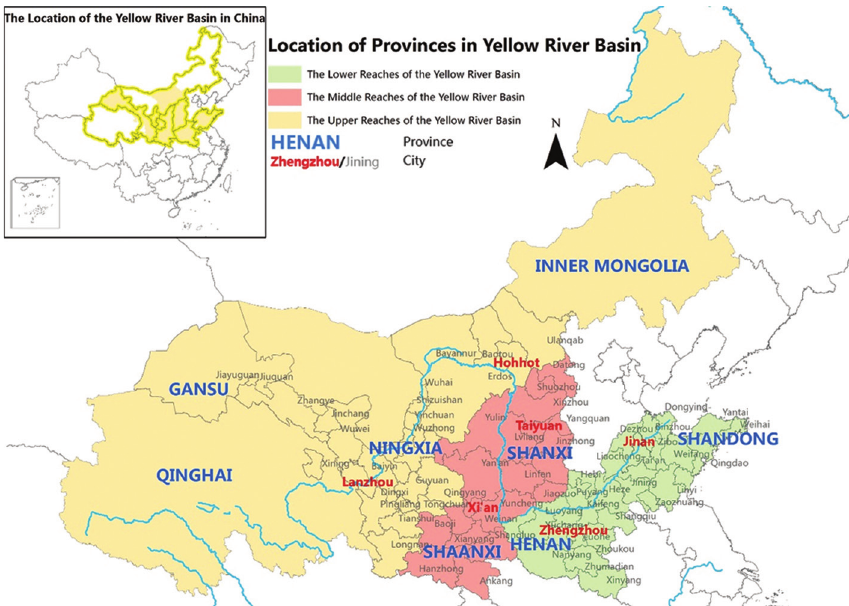
Figure 2: Location of provinces in Yellow River